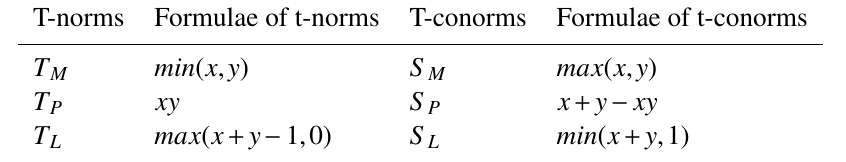
Table 1: Several t-norms and